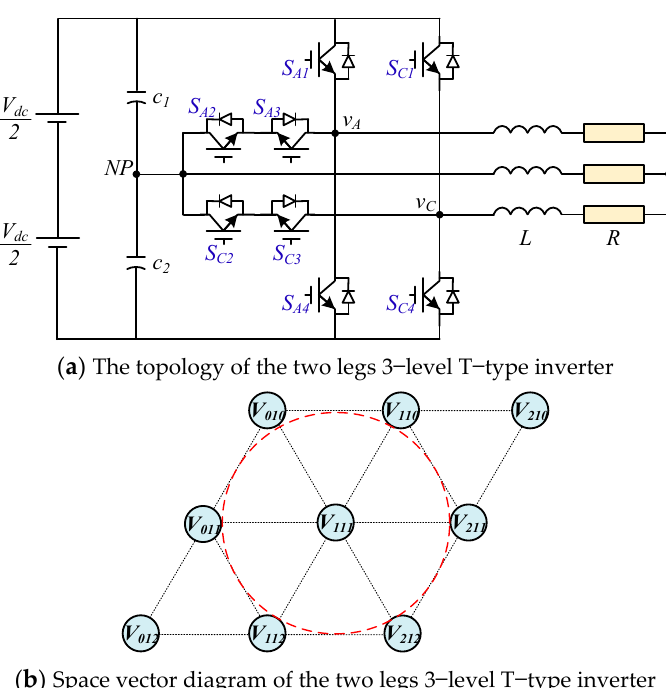
Figure 1. Structure of the two legs T − type 3 − level inverter.